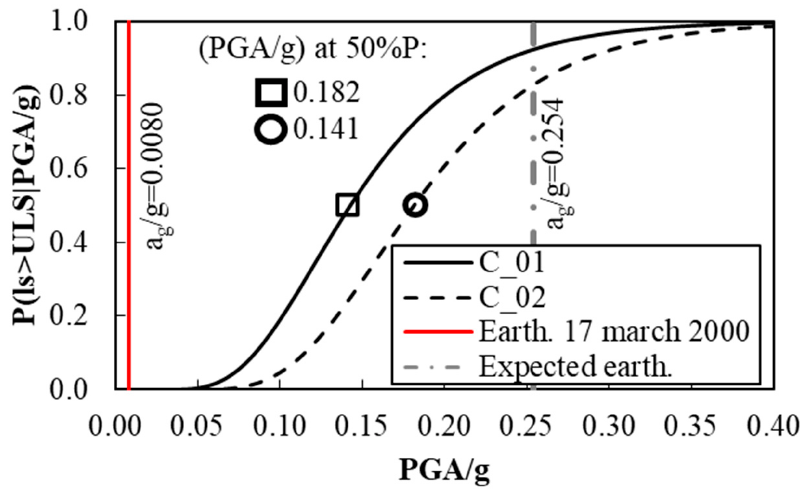
Figure 12. Urban fragility curves for the compartments C01 and C02 of Scilla.